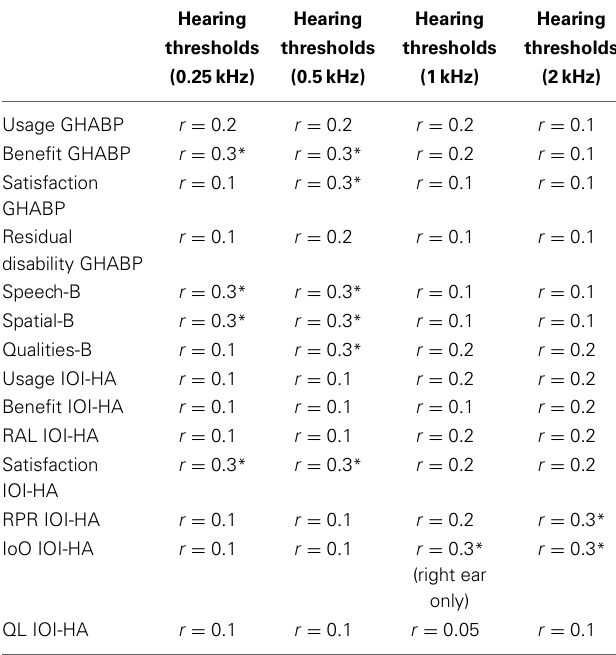
Table 6 | Results of pearson correlation for 6-month follow-up outcomes with degree if hearing